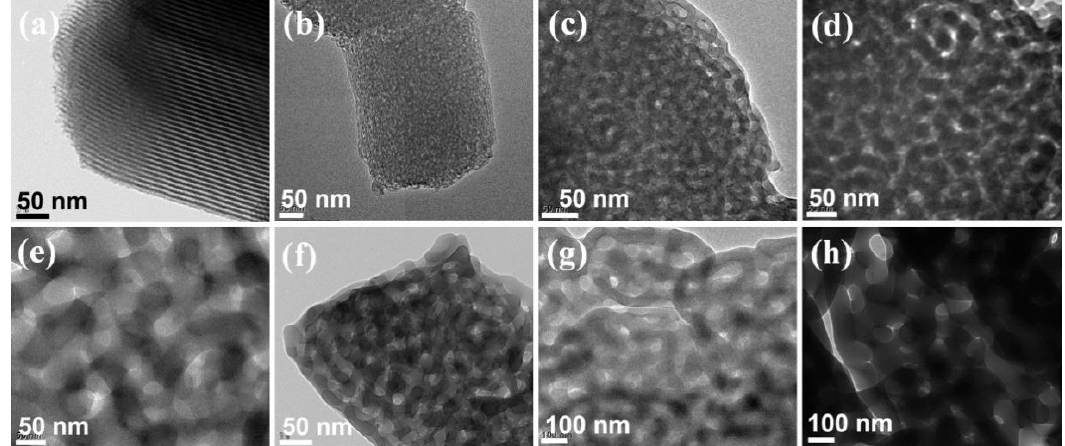
Figure 4. TEM images of ( a ) SBA-15, ( b ) SBA15-Na-80-700, ( c ) SBA15-Na-60-700, ( d ) SBA15-Na-50- 700, ( e ) SBA15-Na-40-700, ( f ) SBA15-Na-30-700, ( g ) SBA15-Na-20-700 and ( h ) SBA15-Na-2.1-700. ( f ) SBA15-Na-30-700, ( g ) SBA15-Na-20-700 and ( h )